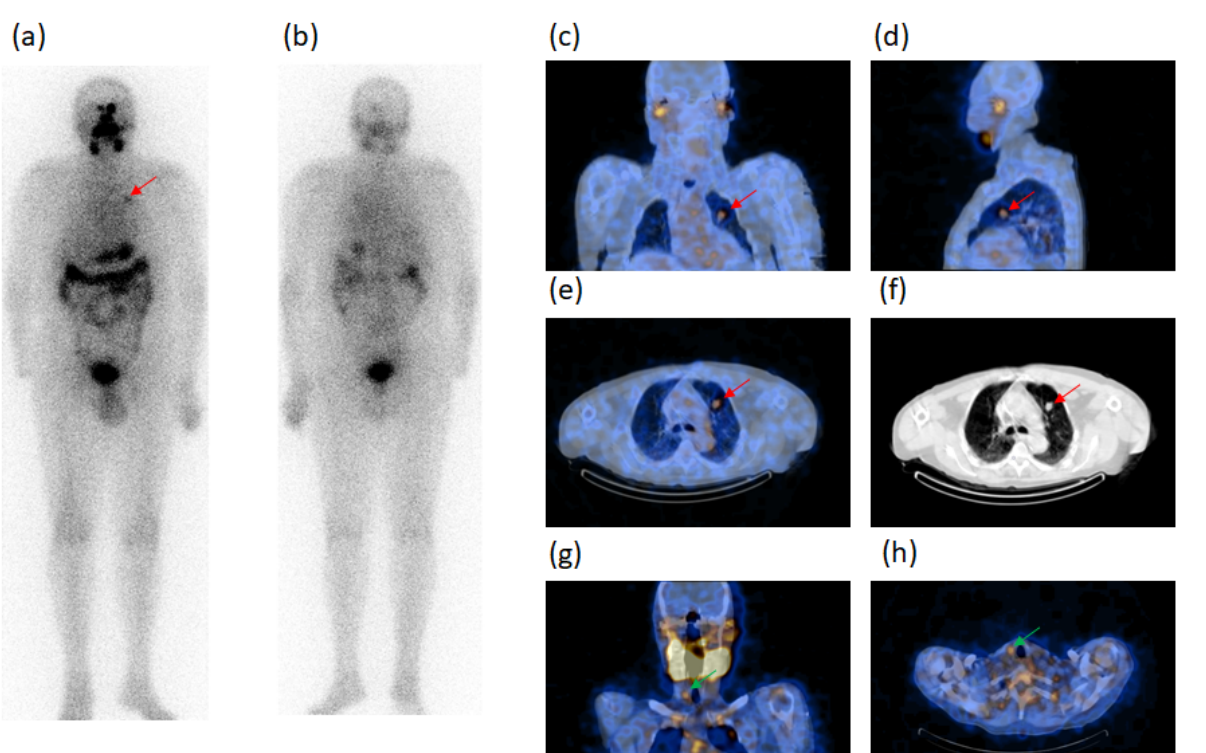
Figure 1. A 73-y-old male patient (case n. 8, Table 3), thyroidectomized for thyroid papillary carcinoma, follicular variant, tumor diameter 25 mm, at the first radioiodine ablation. 131 I-WBS after a therapeutic dose, in both anterior ( a ) and posterior ( b ) views, showed one radioiodine-avid focus in left hemithorax suspected of metastasis (red arrow). Fused SPECT/CT images in coronal ( c ), sagittal ( d ) and transaxial ( e ) slides confirmed the focus (red arrows) specifying the anatomic site (anterior segment of the superior lobe) and characterizing it as lung metastasis, as also confirmed at CT ( f ). In addition, fused SPECT/CT images in coronal ( g ) and transaxial ( h ) slides evidenced another radioiodine-avid focus (green arrows) in the neck corresponding to a right paratracheal lymph node occult at WBS and classified as metastasis. Thyroglobulin levels in hypothyroidism condition: 1362 ng/mL. AbTg: Absent.